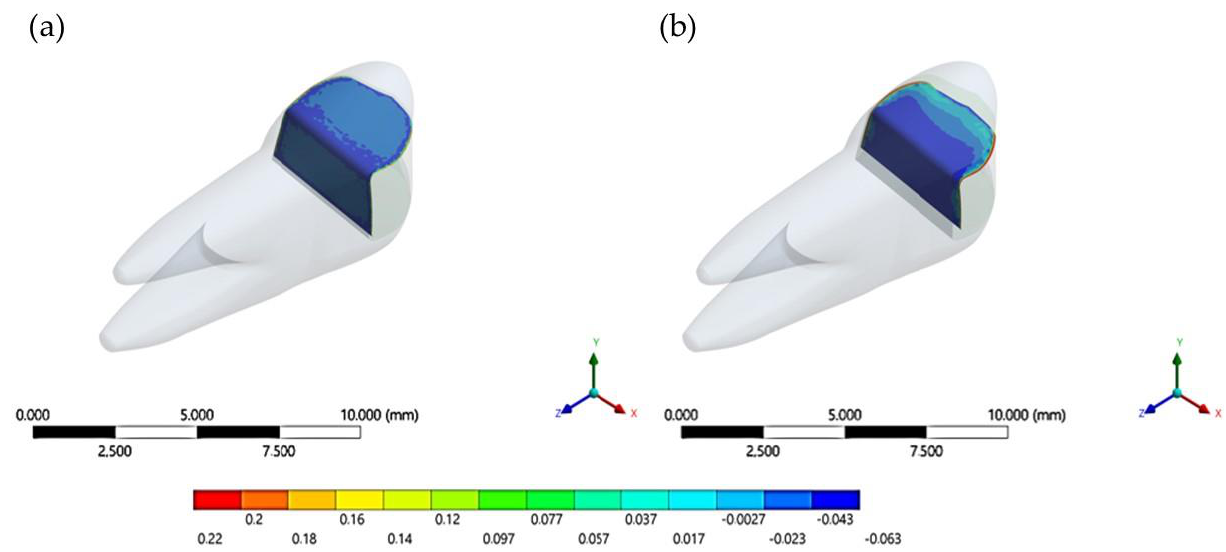
Figure 7. Maximum principal stress in adhesive restoration surface with ( a ) 100 μm cement thickness model and ( b ) 400 μm cement thickness. The stress concentration was higher at the thickness of 400 µm.